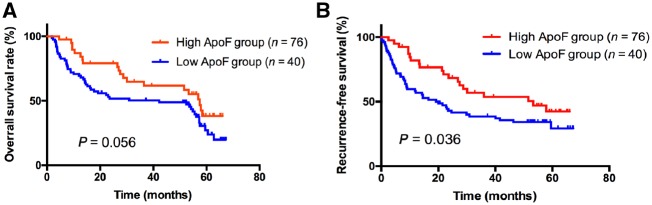
Kaplan–Meier survival analysis according to ApoF protein expression in patients with HCC. (A) Overall survival rate and (B) recurrence-free survival rate. Recurrence-free survival rate was significantly lower in the low-ApoF expression group (solid line) than in the high-ApoF expression group (dotted line) (P = 0.036).